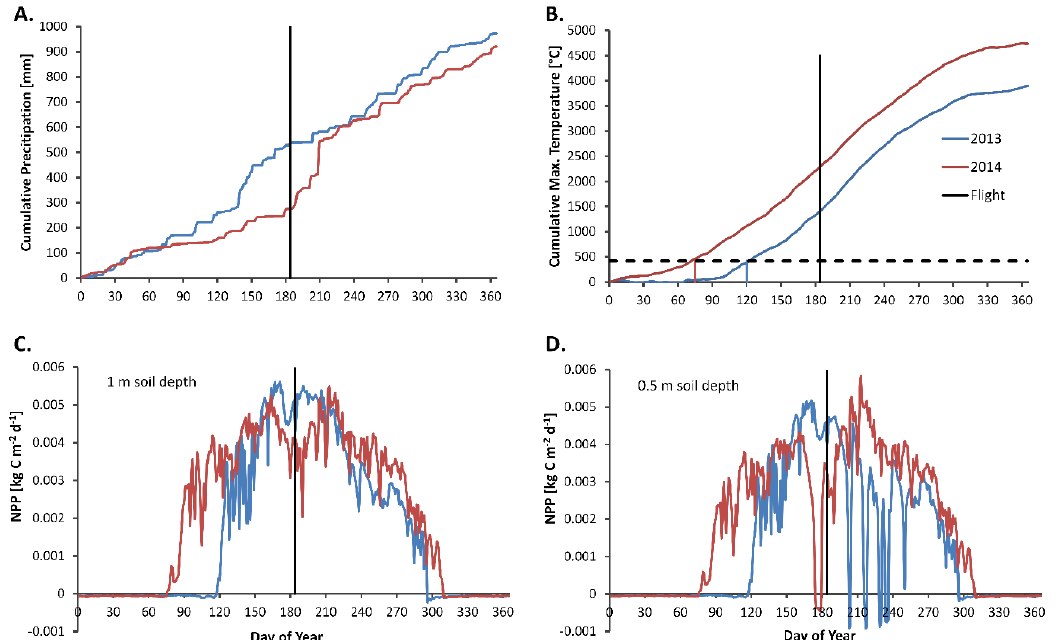
Figure 2. Climate data and BiomeBGC simulations of net primary productivity (NPP) in 2013 (red) and 2014 (blue). The HySpex overflight on day of year 184 is marked by black lines. ( A ) Cumulative precipitation. ( B ) Cumulative daily maximum temperatures. The start of the growing season at 420 °C cumulative temperature is marked. ( C ) NPP for 2013 and 2014 for 1 m soil depth and ( D ) 0.5 m soil depth.